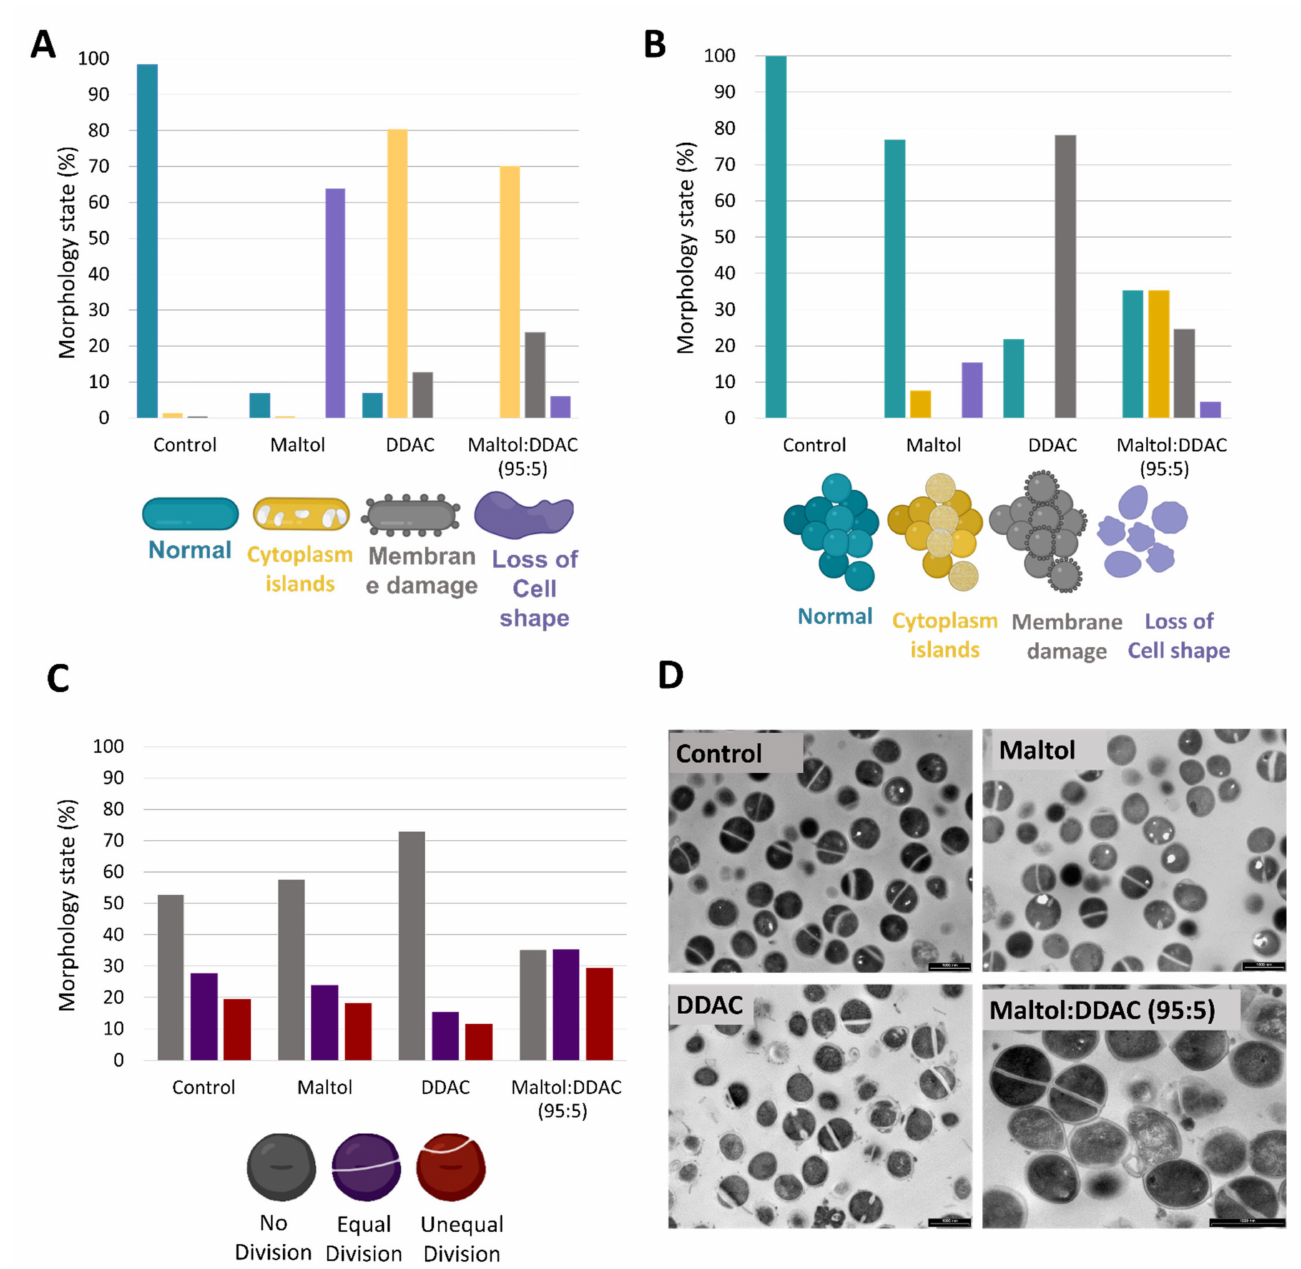
Figure 12. TEM images analysis of ( A ) Pseudomonas aeruginosa treated with H 2 0, no treatment control, maltol at 4500 ppm, DDAC at 500 ppm and a blend of maltol and DDAC (95:5) at 5000 ppm. ( B ) Analysis of Staphylococcus aureus TEM images treated with H 2 0, no treatment control, maltol at 4500 ppm, DDAC at 500 ppm and a blend of maltol and DDAC (95:5) at 5000 ppm. Turquoise indicating normal cells, Yellow indicating cells with cytoplasm islands, Dark gray indicating membrane damage, and purple indicating loss of cell shape. ( C ) Cell cycle analysis of S. aureus treated with H 2 0, no treatment control, maltol at 4500 ppm, DDAC at 500 ppm and a blend of maltol and DDAC (95:5) at 5000 ppm. Dark gray indicating normal cells, purple indicating equal division and red indicating unequal cell division. ( D ) Visual example of the treated cells. 150–200 cells were counted manually based on three fields of view, while results are presented as the percentage of cells with the observed